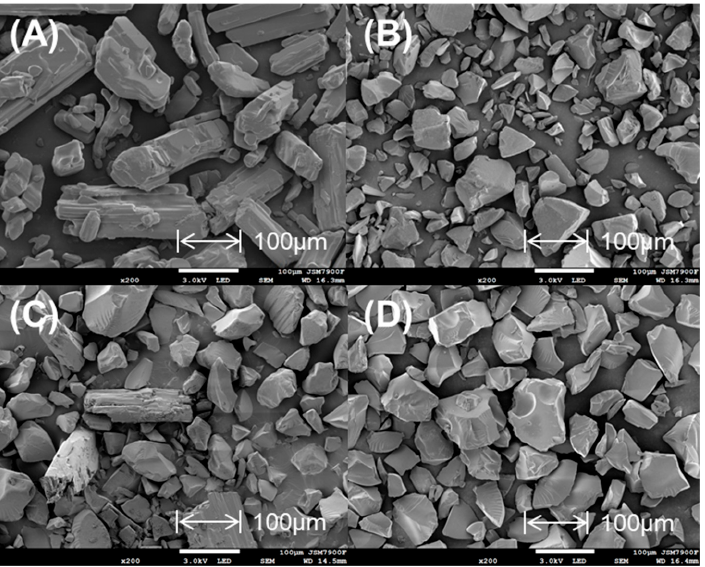
Figure 2. SEM images of ( A ) methylphenidate hydrochloride, ( B ) Amberlite IRP69, ( C ) a mixture of methylphenidate hydrochloride and Amberlite IRP69, ( D ) drug–resin complex. DSC patterns of methylphenidate hydrochloride exhibited endothermic peaks at around 225 °C (Figure 3), which was close to the intrinsic melting points. In the mixture of methylphenidate hydrochloride and Amberlite IRP69, there still could be found a similar sharp peak. Whereas the DSC curves of the drug–resin complex were similar to the ones of Amberlite IRP69, in which there was not observed a sharp peak. The peaks associated with methylphenidate hydrochloride did not appear in the drug–resin complex. The DSC patterns showed that the drug changed from the crystal structure to another form due to be loaded on the ion exchange resins.